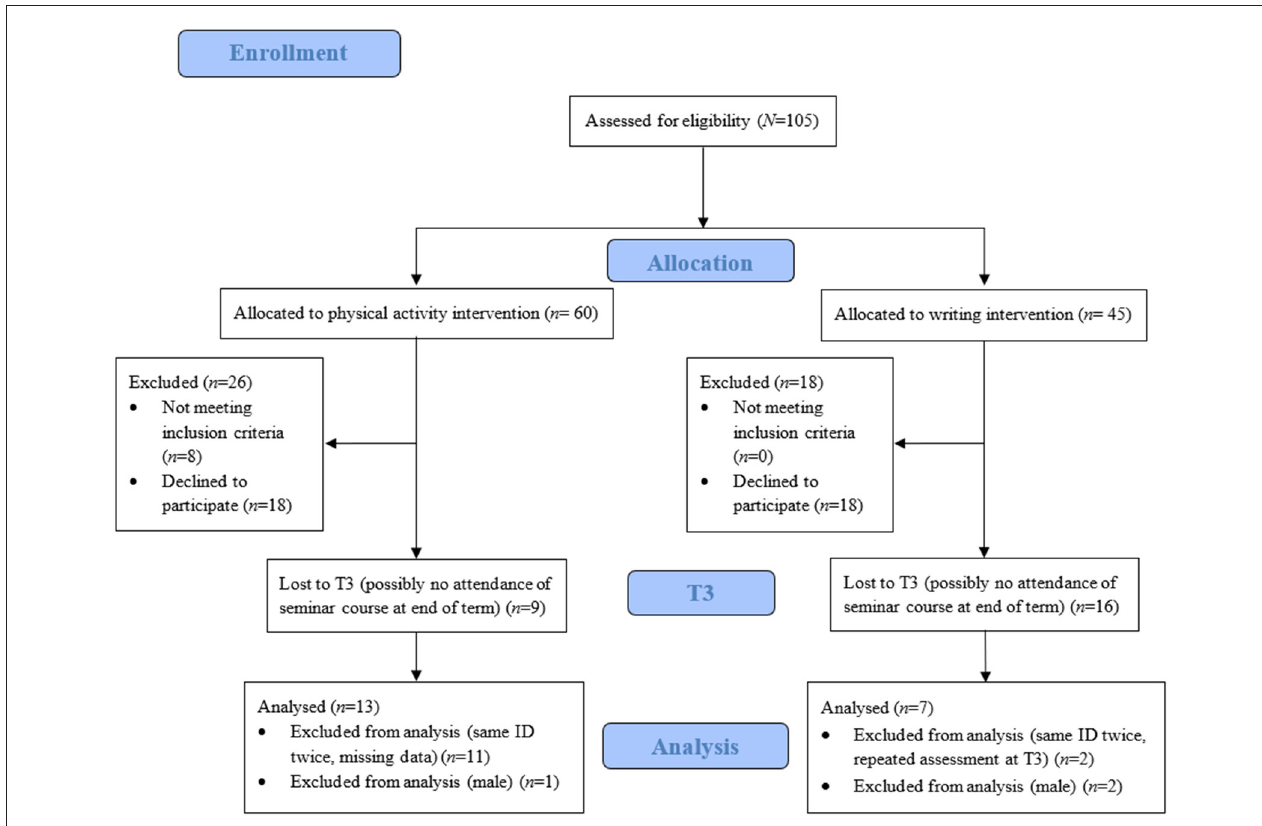
FIGURE 1 | CONSORT diagram depicting dropout numbers, participation numbers and numbers of analysis in the online